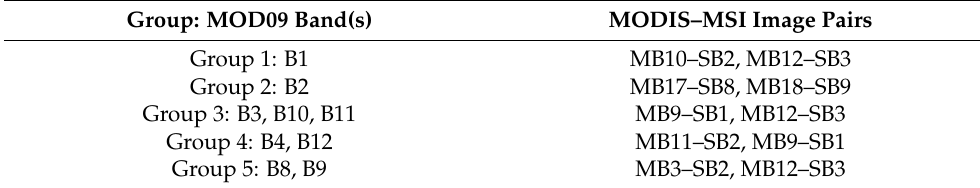
Table 3. Two strongly correlated MODIS–MSI band image pairs for each group. Bands with the same group shared the same two MODIS–MSI band image pairs (e.g., B4 and B12 shared the same two MODIS–MSI band image pairs: MB11–SB2 and MB9–SB1). (MB: MODIS band, SB: Sentinel-2 MSI band; numbers denote certain bands). Group: MOD09 Band(s) MODIS–MSI Image Pairs Group 1: B1 Group 2: